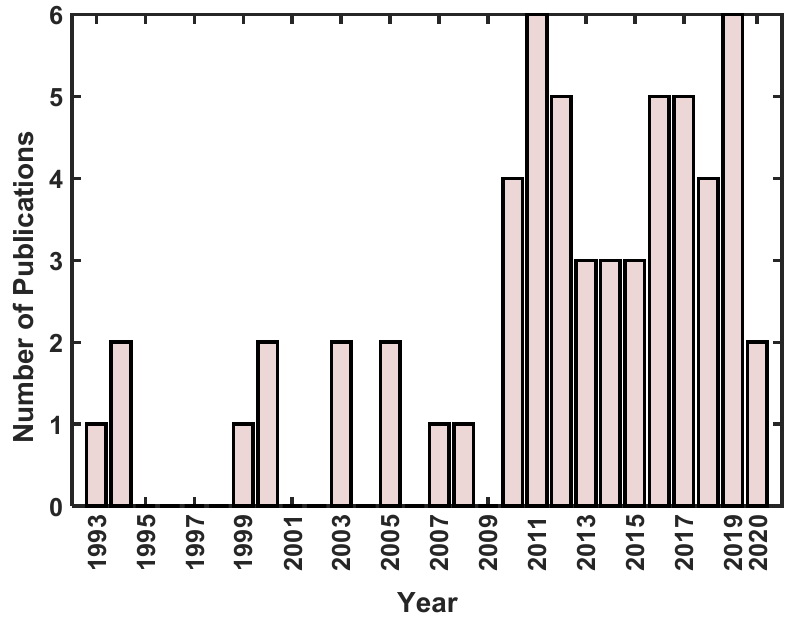
Figure 1. Trend showing the number of publications on HMM-based diagnostics and prognostics over the past three decades, focusing on mechanical components such as bearings, shafts, turbofans, and turbines.